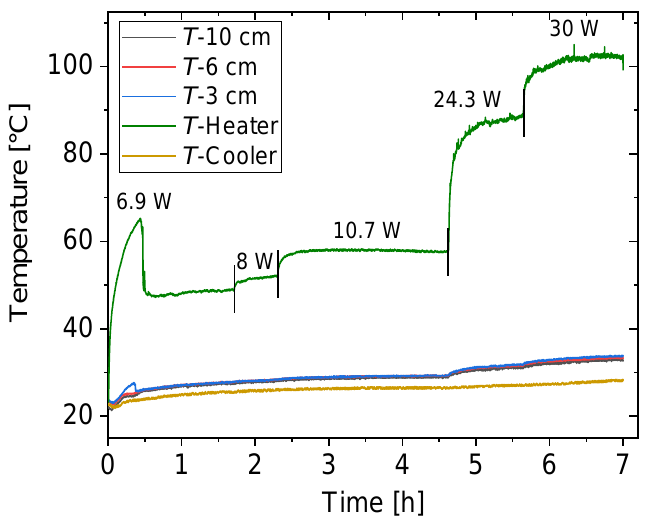
Figure 14. Second sequence of temperatures measured along heat pipe vs. time for different heating powers (temperature measurement locations as defined in Figure